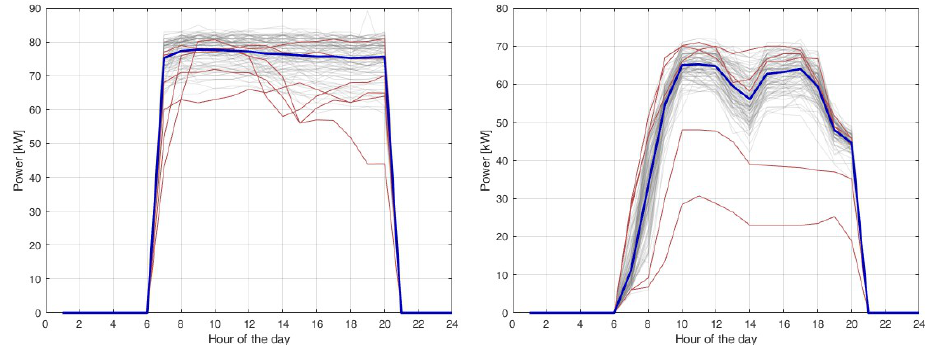
Figure 5. Results of the data cleaning and averaging phase: in grey, all 175 daily measurements of the load are shown; in red, the outliers are highlighted; and in blue, the average load is shown.